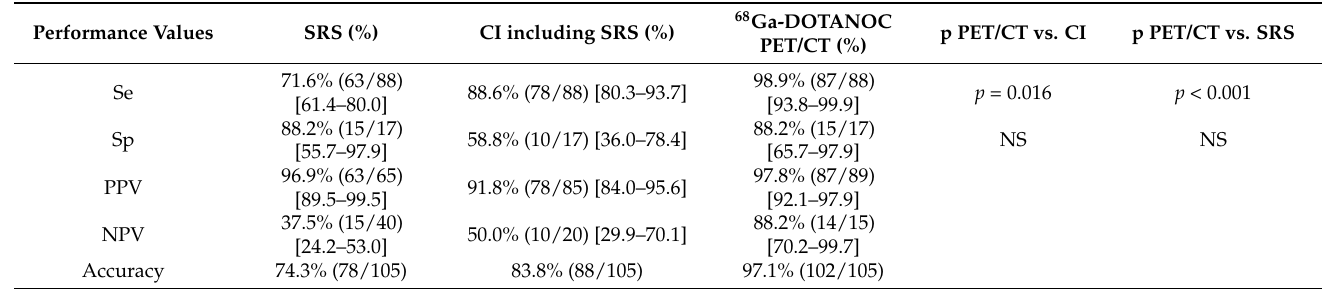
Table 3. Sensitivities, specificities, positive predictive values, negative predictive values and accura- cies of SRS, Conventional Imaging and 68 Ga-DOTANOC PET/CT at Patients’ levels.